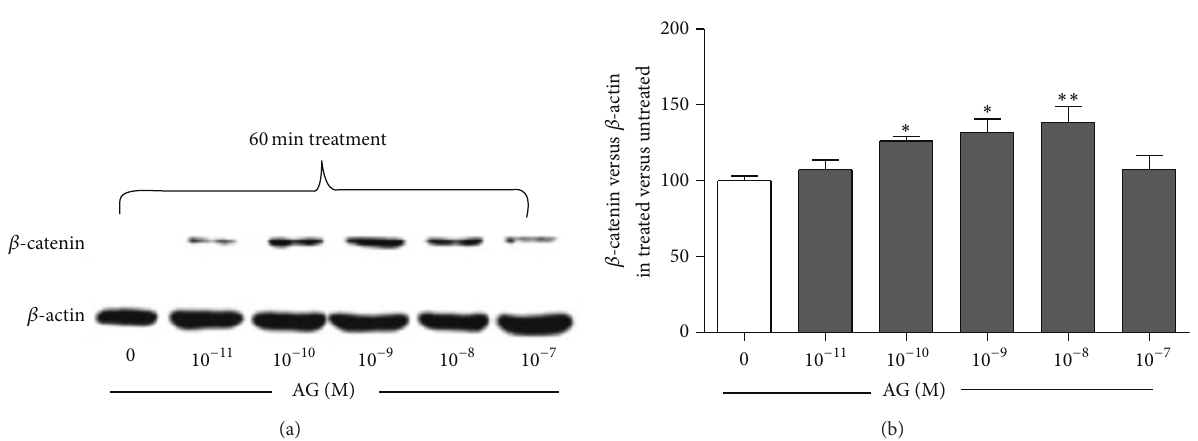
Figure 1: Representative Western blot (a) and quantification (b) of the effect of increasing concentrations of ghrelin (AG, 10 −11 –10 −7 M, 1h treatment) on 𝛽 -catenin protein level in whole cell lysates of rat osteoblast-like cells. 𝛽 -catenin levels are normalized on 𝛽 -actin protein levels and results are expressed as the ratio of 𝛽 -catenin amount measured in treated cells to the amount obtained in untreated cells. Data are the mean ± SEM of five experiments ∗ 𝑃 < 0.05 , ∗∗ 𝑃 < 0.01 versus untreated cells.